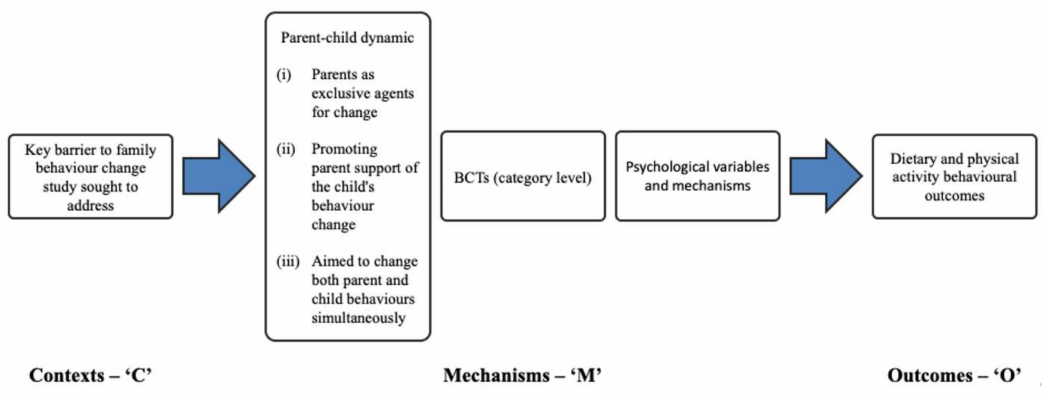
Figure 1. Program theory